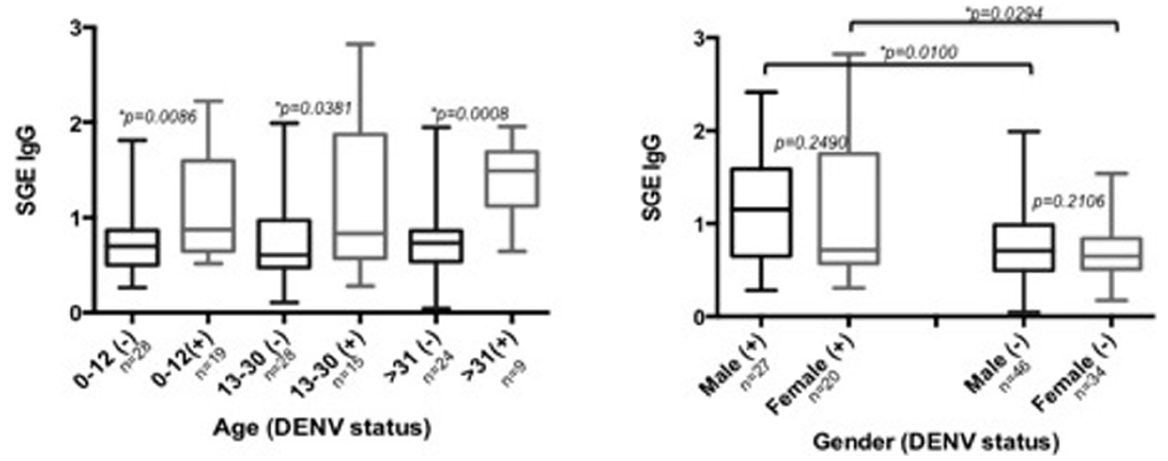
Figure 3. Concentration of anti- Ae.aegypti SGE antibodies according to gender and age categories in participants infected with DENV-RNA ( + ) versus participants without DENV-RNA ( 2 ) infection. Statistical significance of Mann-Whitney test (*) p , 0.05.